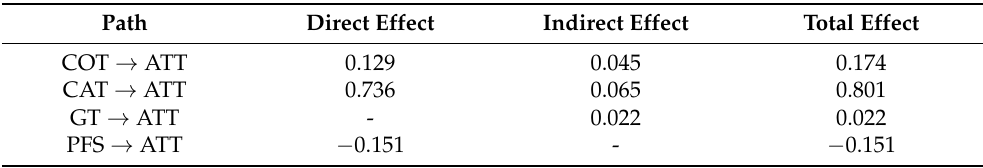
Table 6. Direct Effect, Indirect effect, and Total effect (Public’s attitude toward the high qualified rate of safety supervision sampling inspection of commonly consumed foods.).